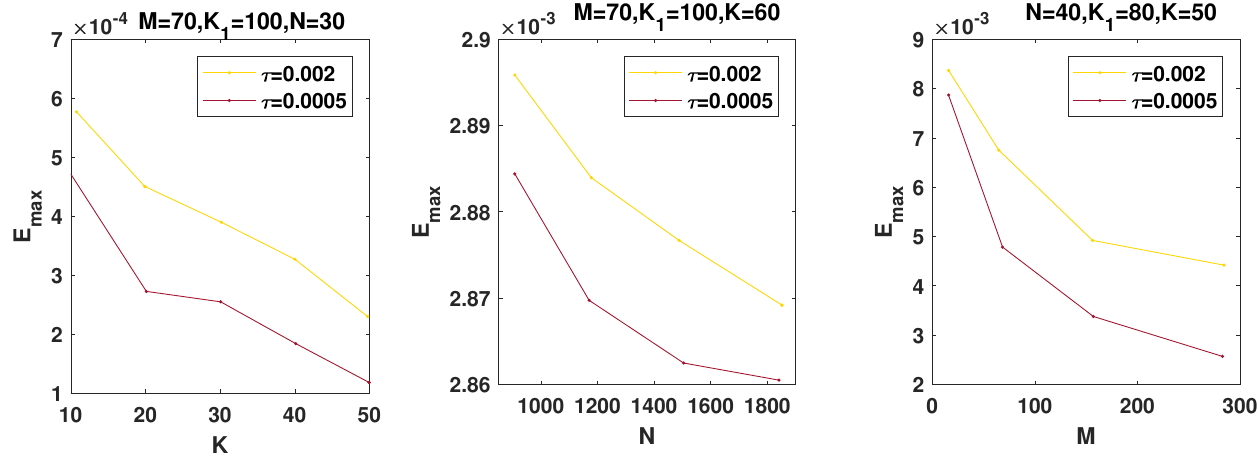
Figure 17. E max –error of u M at T = 1, c = 0.1, ν = 1, and α = 10 for Example